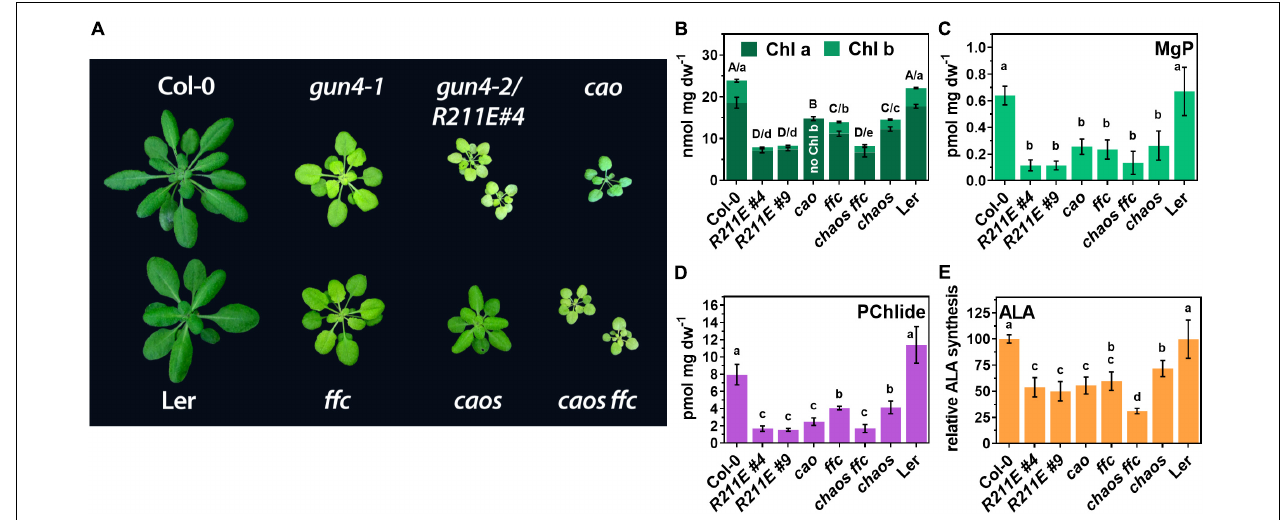
FIGURE 6 | Comparison of gun4 mutants with mutants impaired in the accumulation of photosynthesis proteins. (A) Phenotype of 6-week old WT (Col-0) and mutant plants grown on soil under short-day conditions at 100 µ mol photons – 2 s – 1 . In addition to gun4-1 and the gun4-2/R211E mutant, single and double mutants for the chloroplast signal recognition particle (cpSRP) 43 ( chaos ) and cpSRP54 ( ffc ) and the knock out mutant for the chlorophyll a oxygenase ( cao ) are shown. Chaos mutant is in Ler background. (B) Chl a and b, (C) MgP, (D) PChlide content, and (E) ALA-synthesis capacity in 21 days old plants grown in short-day (SD). Significance groups (* p < 0.05) were calculated using one-way ANOVA and Turkey’s multiple comparison test with n ≥ 5 replicates from two independent experiments. Values are given as the mean ± S.D.